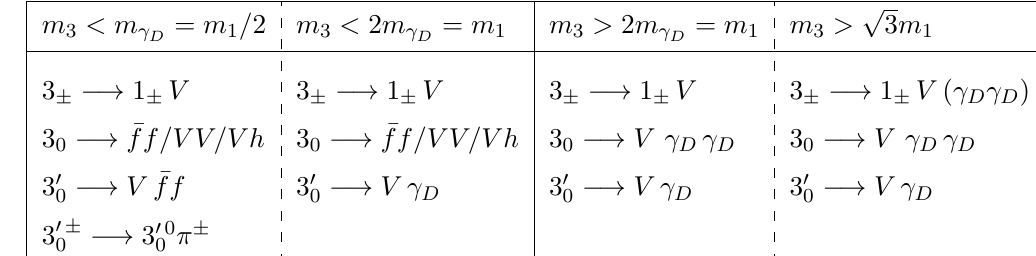
Table 4 . Main triplet decay modes in the various kinematic regimes, assuming m 1 = 2 m γ V can be any electroweak gauge boson, depending on the electromagnetic charge of the initial triplet, h is the Higgs boson, while ¯ ff denotes a pair of SM fermions. In the case of inverted hierarchy, decays among different components of the 3 0 rate of 3 0 → V ¯ ff is 0